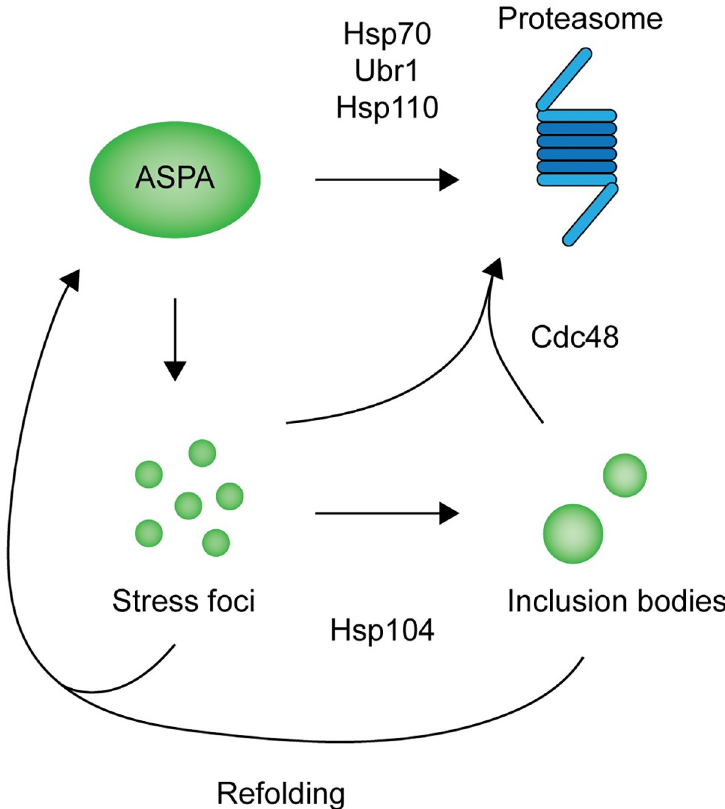
Fig 7. Illustration of our model for ASPA degradation in budding yeast. ASPA C152W is targeted to the proteasome for degradation by Hsp70, Hsp110, and E3 ubiquitin-protein ligases including Ubr1. In addition, ASPA C152W forms aggregates that are dissolved by Hsp104 to promote sorting of ASPA into inclusion structures as well as refolding to form soluble ASPA. Finally, Cdc48 mediates degradation of insoluble ASPA